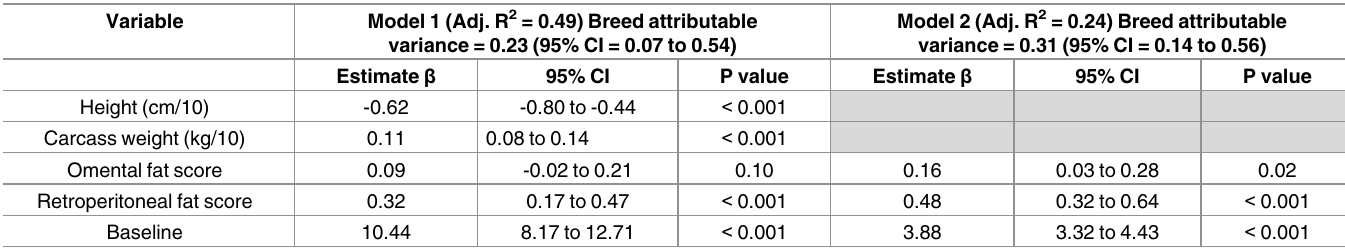
Table 6. Associations between EQUIFAT scores and BCS.